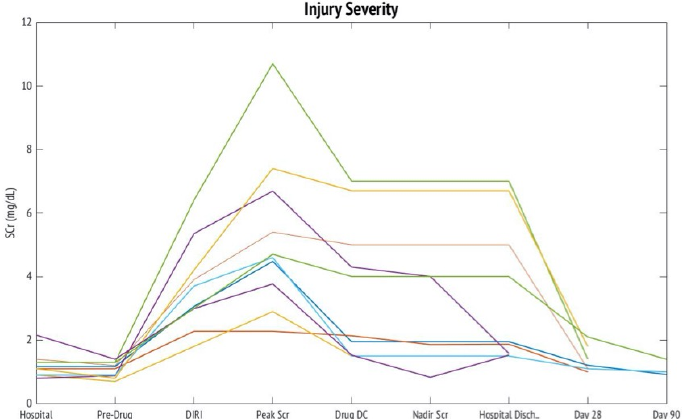
Figure 1. Changes in Serum Creatinine over V-AKI Course. This figure depicts the changes in serum creatinine in 10 cases over the course of vancomycin associated acute kidney injury from hospital admission through day 90 post injury. The time points correspond to Drug Induced Renal Injury Consortium (DIRECT) study time points. Abbreviations: SCr = serum creatinine, Hospital = hospital admission, Predrug = prior to drug exposure, DIRI = drug induced renal injury definition met, Drug DC = drug discontinuation or dose reduction, Nadir Scr = lowest serum after V-AKI, Hospital Disch = hospital discharge.